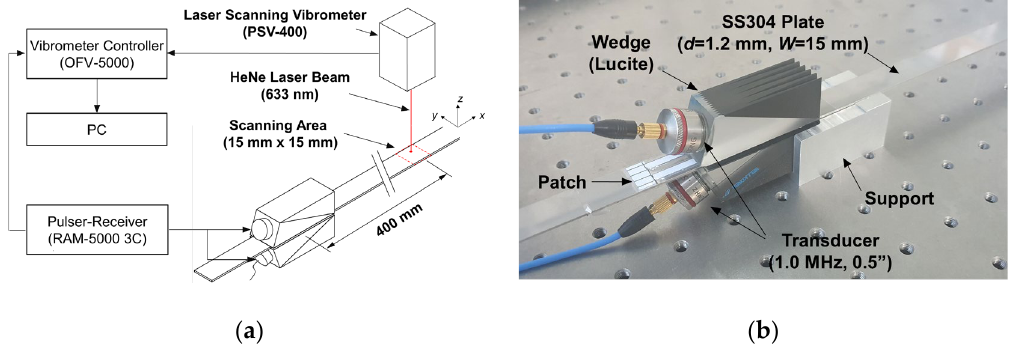
Figure 12. ( a ) Schematic diagram of the experimental setup and ( b ) installed patch-based wedges for Lamb wave propagation measurement in a finite-width plate using a laser scanning vibrometer.